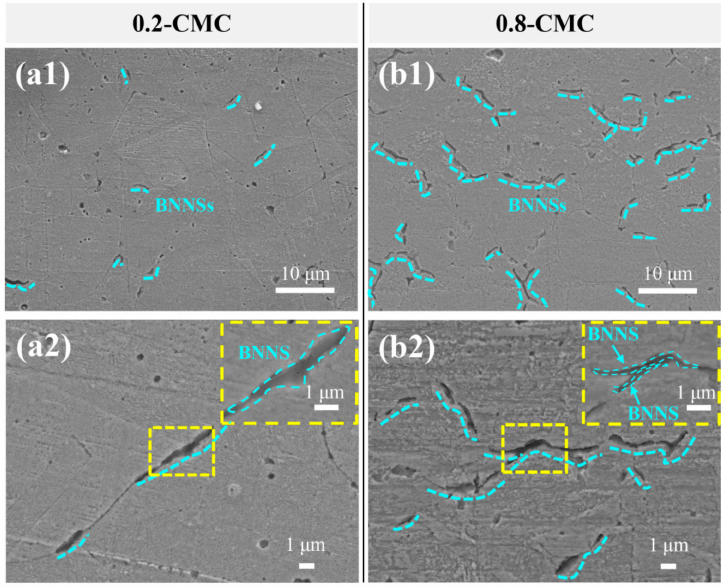
Figure 5. Microstructural characterization of the etched composite sample: ( a1 , a2 ) 0.2-CMC; ( b1 , b2 )